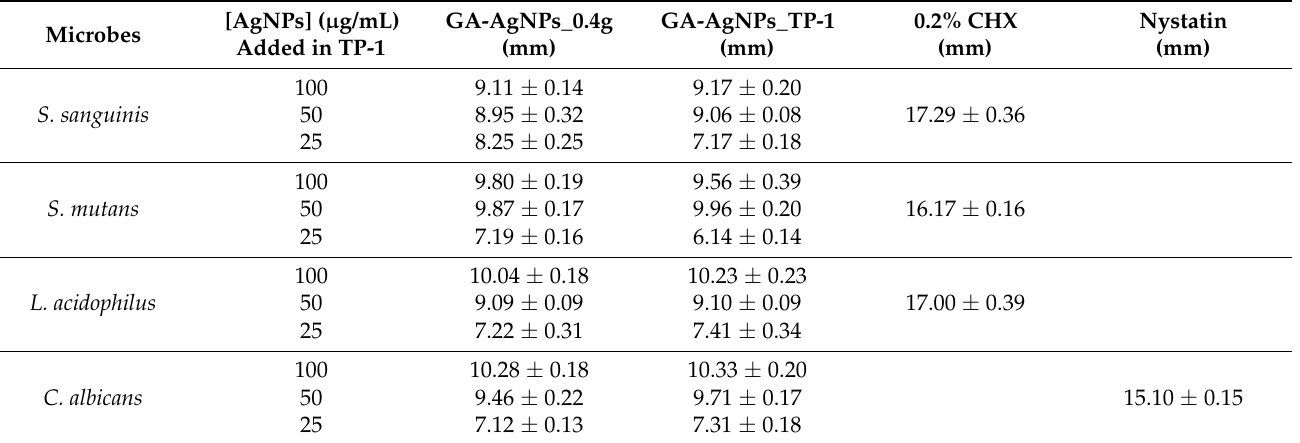
Table 3. Antimicrobial activity of GA-AgNPs_0.4g and GA-AgNPs_TP-1 measured as ZOI against selected